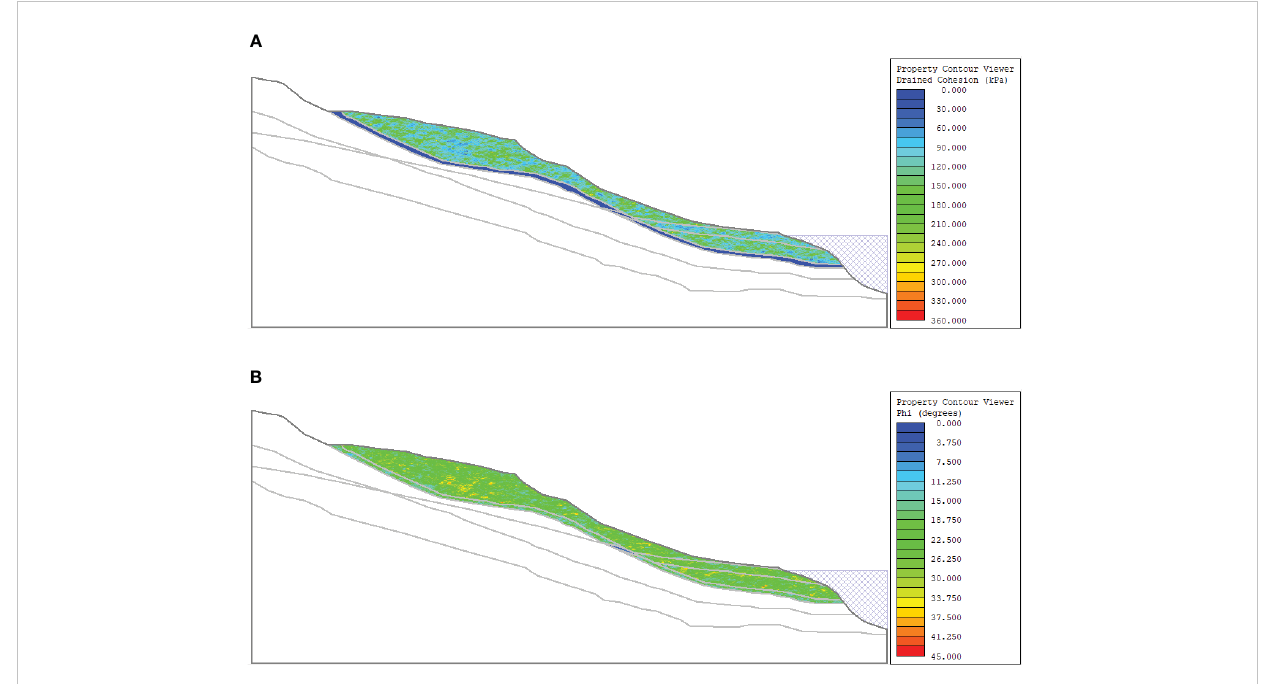
FIGURE 5 Random fi eld model of Zhaoshuling landslide: (A) Random fi eld model of cohesion; (B) Random fi eld model of internal friction angle.